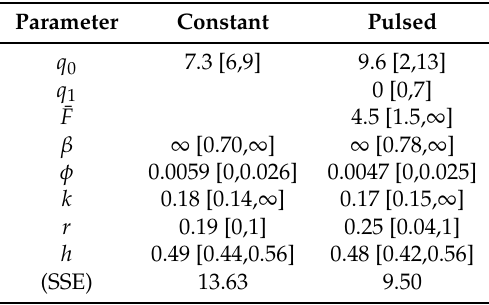
Table 4. Fitted parameters for Patil et al.’s dataset under constant and pulsed secretion rate models. Confidence intervals are at the 95% level. IFN and viral units are in terms of